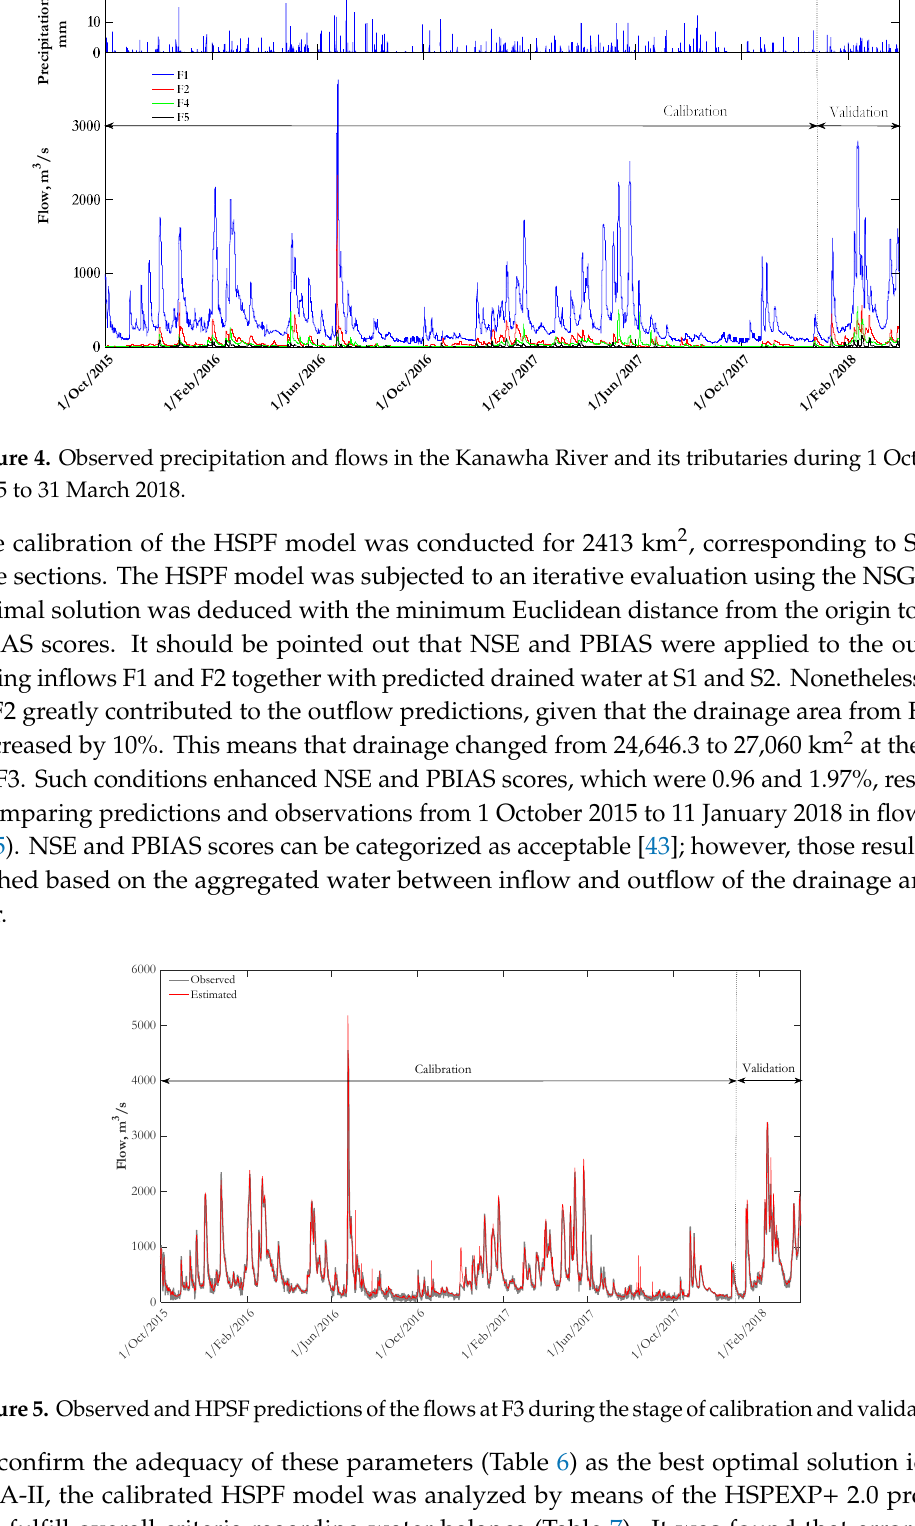
Figure 5. Observed and HPSF predictions of the flows at F3 during the stage of calibration and validation.